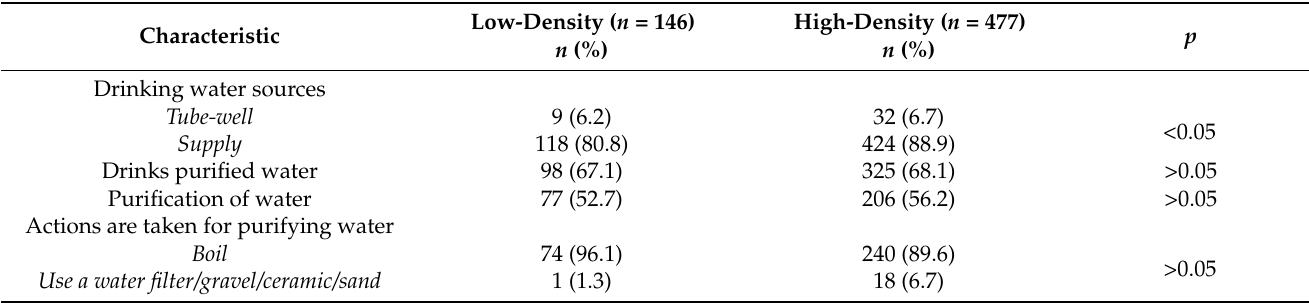
Table 4. Comparison of WASH practices among neighborhood contacts in low-density and high- density